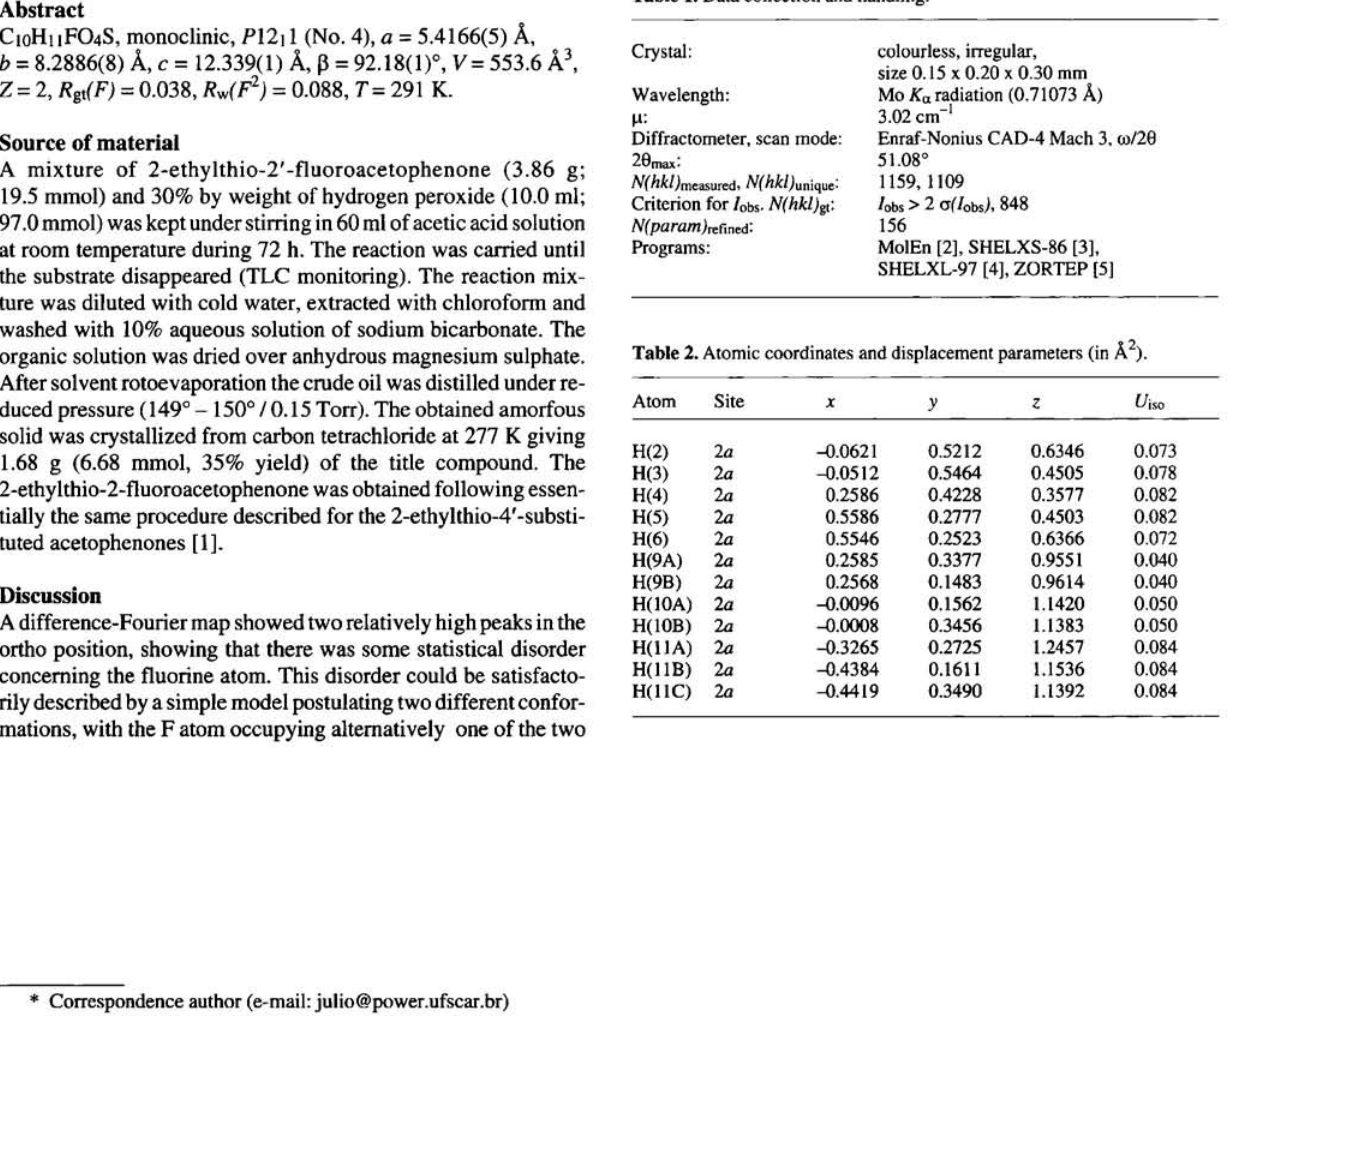
Table 1. Data collection and handling.